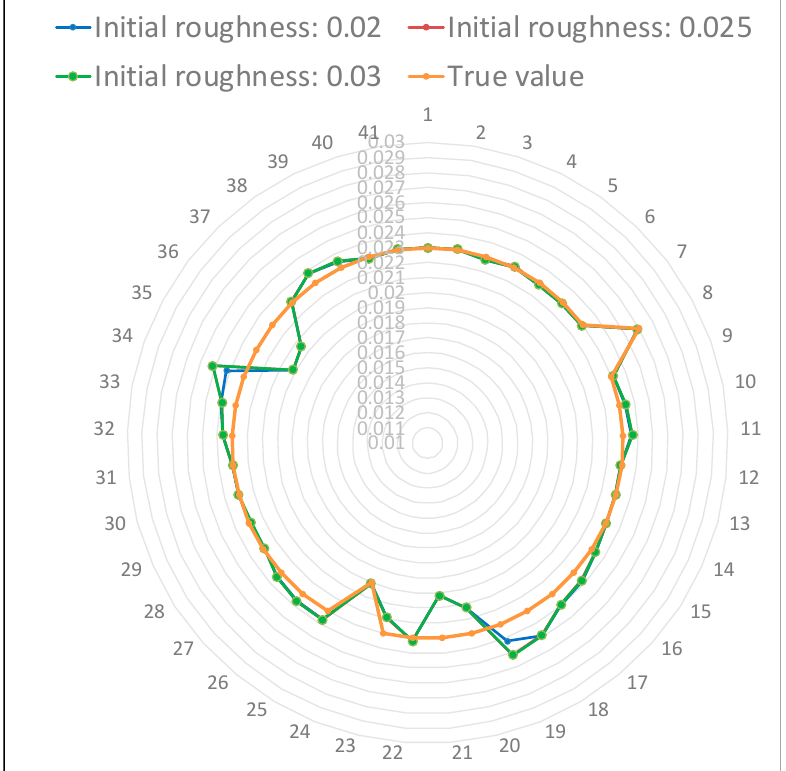
Figure 8. Roughness inversion results at all section nodes with different initial roughness values.